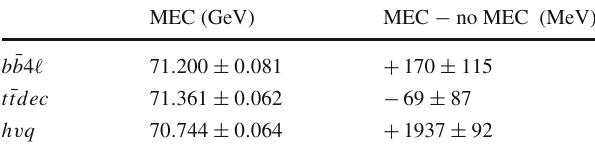
Fig. 15 Logarithmic energy distribution obtained with the three gen- erators interfaced to Pythia8.2 , together with their polynomial fit, in for each generator the range displayed in the figure. The value of E max b j is also reported Table 15 E b peak position obtained with the three generators show- j ered with Pythia8.2 . The differences between the peak positions extracted by switching on and off the matrix-element corrections are also